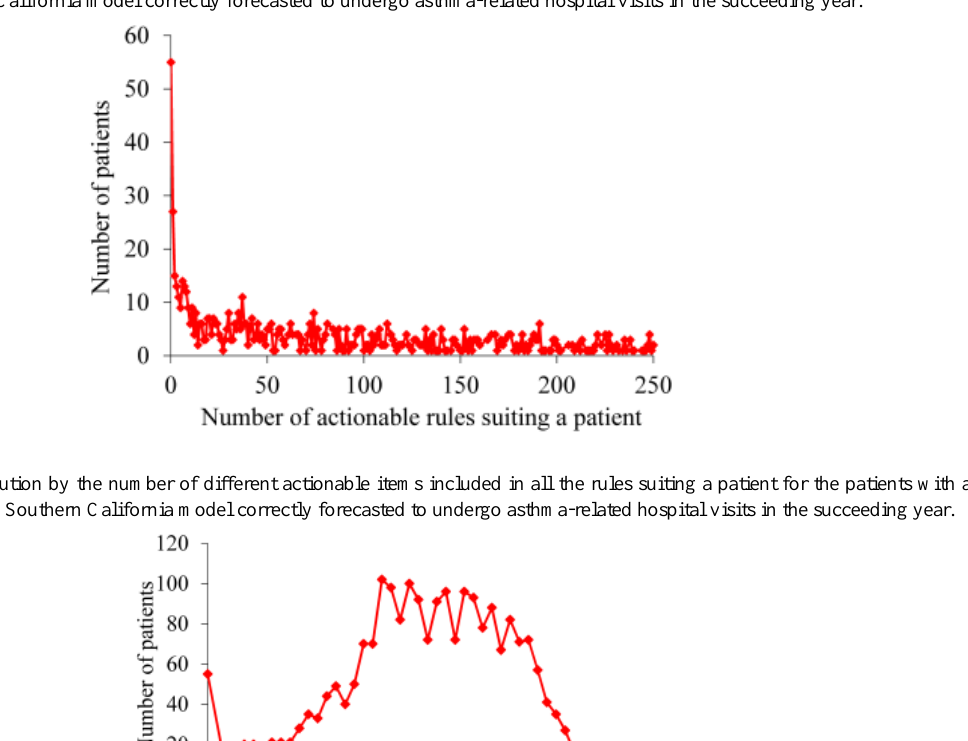
Figure 3. The patient distribution by the number of actionable rules suiting a patient when this number is ≤ 250 for the patients with asthma whom our Kaiser Permanente Southern California model correctly forecasted to undergo asthma-related hospital visits in the succeeding year.